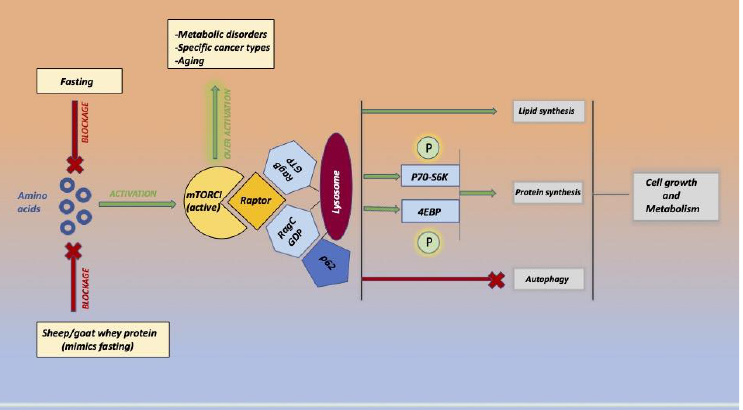
Figure 5. The image represents the molecular pathway of related amino acid activation of the mam- malian target of rapamycin complex 1 (mTORC1) and the beneficial action of sheep/goat whey pro- tein administration that imitates the fast. Mtor regulates different cellular processes, such as cell growth and proliferation, autophagy, and protein synthesis, and exists in two forms, mTORC1 and